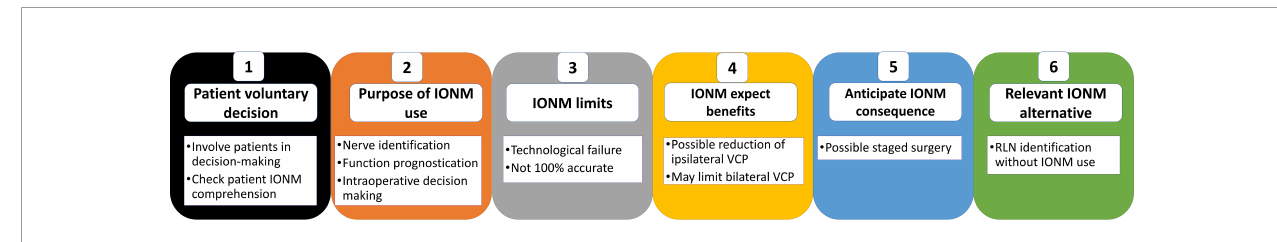
FIGURE 3 | IONM Informed Consent. Diagram showing key information of the preoperative encounter and IONM informed consent process. It is necessary to document the parties involved in the informed-consent